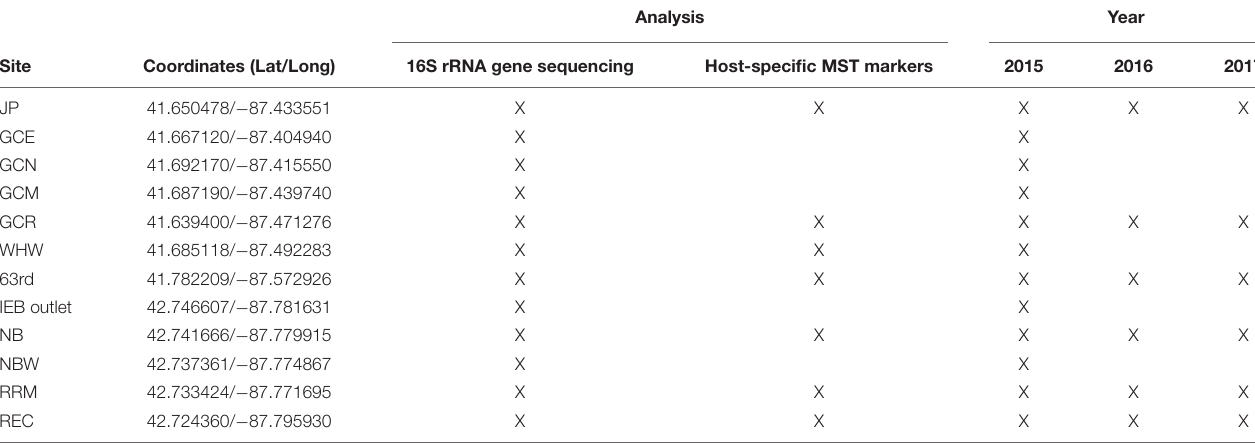
TABLE 1 | Study locations, sampling years, and the measured microbial endpoints (16S rRNA gene sequencing and two host-specific MST markers) in coastal waters along southern Lake